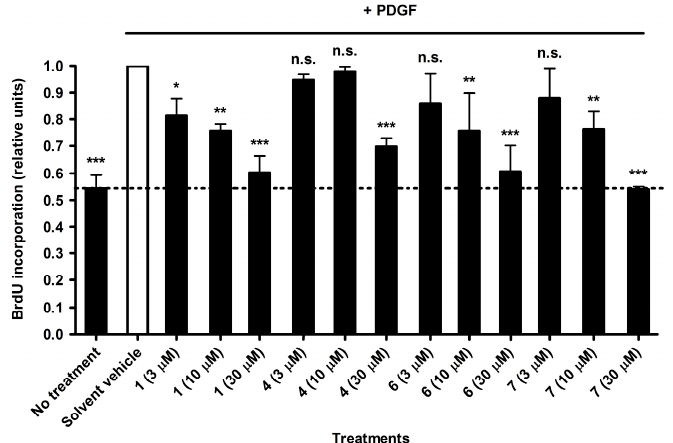
Figure 3. Inhibition of VSMC proliferation by compounds 1 , 4 , 6 , and 7 measured with the BrdU assay. Values are presented as means ± SD, relative to the PDGF stimulated solvent vehicle control (0.1% DMSO) ( n = 3). *** p < 0.001, ** p < 0.01, * p < 0.05, n.s. not significant (ANOVA/Bonferroni).